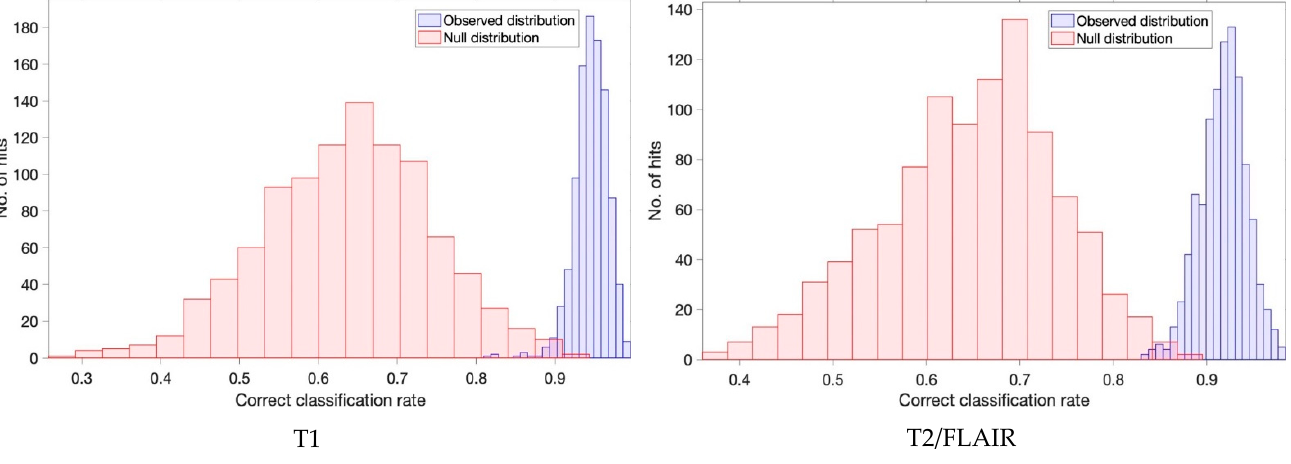
Figure 3. Null (red) and observed (blue) distribution classification rates for both the T1 and T2/FLAIR cohorts with a PLS-DA classification model after 1000